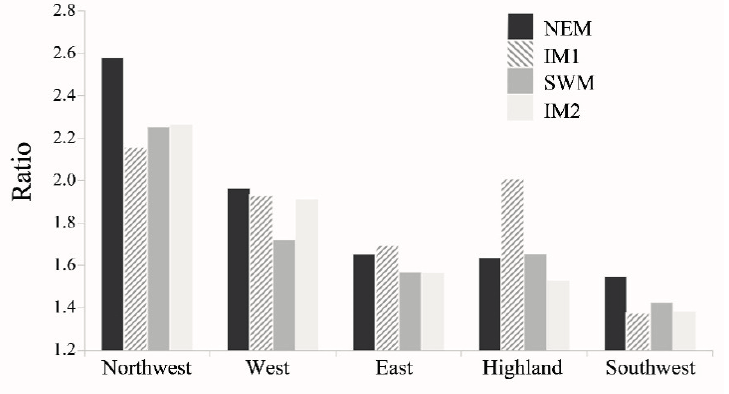
Figure 8. Average seasonal ratio values between TRMM rainfall estimates and ground rainfall in local climate regions.